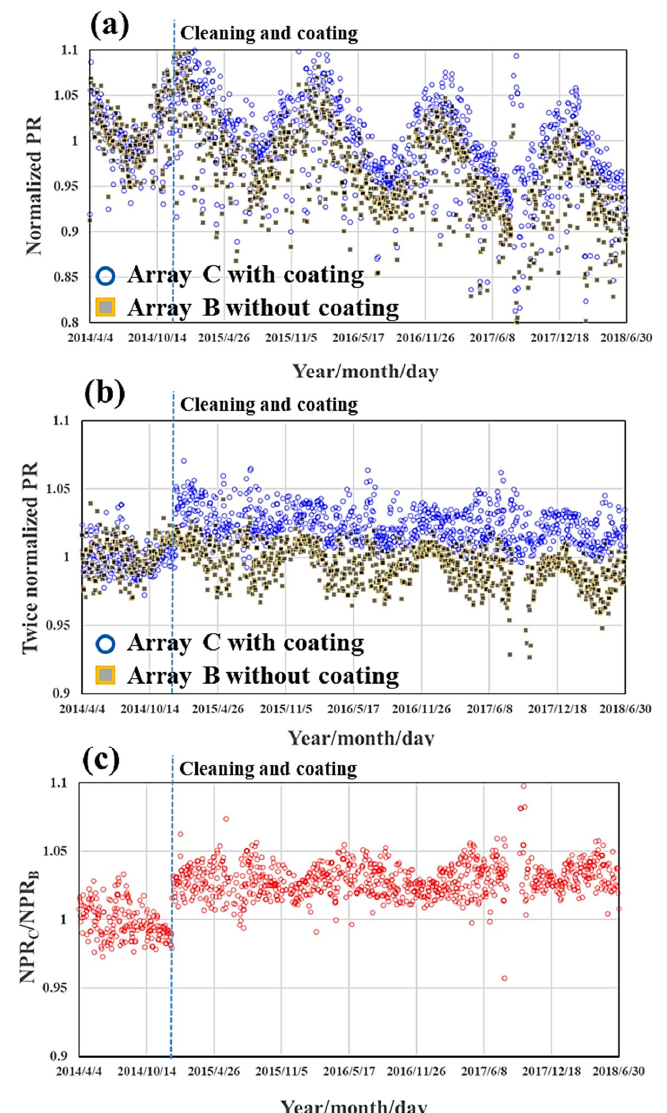
Figure 2. ( a ) Normalized daily PR of arrays B (NPR B ) and C (NPR C ), ( b ) twice normalized daily PR of arrays B and C (NPR B and NPR C were divided by the normalized daily PR of reference array A), and ( c ) NPR C /NPR B .